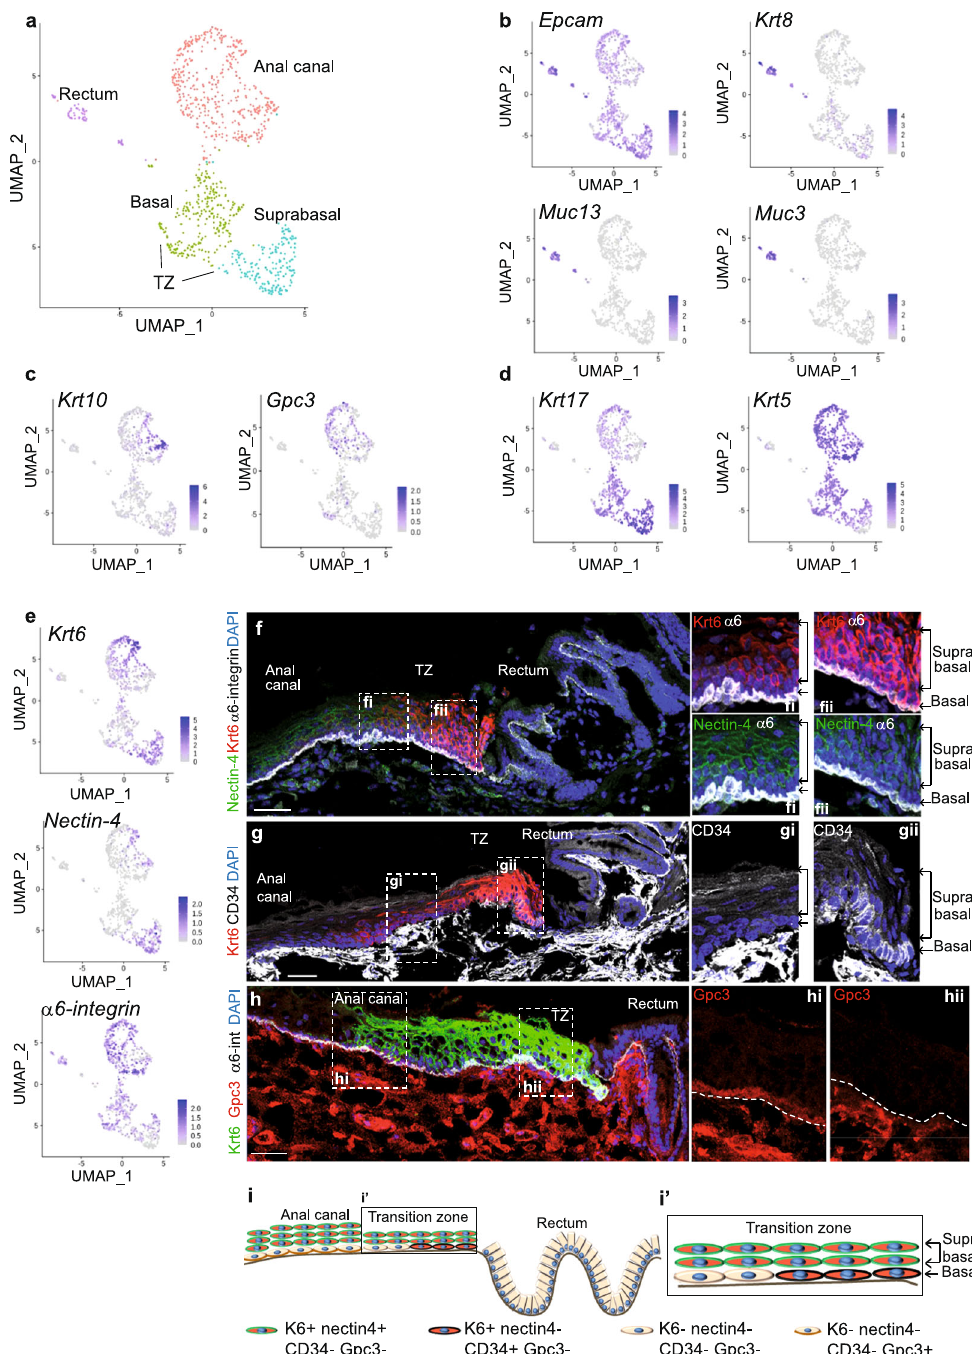
Fig. 2 Single cell analysis reveals hierarchical organization of the anal TZ cells. a Main cell populations visualized on Uniform Manifold Approximation and Projection (UMAP) dimensional reduction from scRNA sequencing of anorectal epithelial cells. Nine hundred and thirty-nine cells are visualized and colored by clustering. b – d Expression of key genes expressed in rectum, differentiated anal cells and TZ populations respectively. Darker color in the UMAP plot indicates higher expression level of the selected gene. e Expression of Krt6 and nectin-4 genes de fi nes the suprabasal TZ population. f Immuno fl uorescence with Krt6 (red), nectin-4 (green) antibodies con fi rms that TZ population can be separated into basal (expressing the polarized α 6-integrin in white) and suprabasal clusters ( n = 3 independent experiments from three mice). Scale bar is 50 μ m. fi , fi i are zoom 2,5-fold into the TZ closed to the anal canal and the rectum respectively. g Immuno fl uorescence with Krt6 (red), and CD34 (white) shows that TZ basal cells closed to the rectum express the stem cell marker CD34 ( n = 3 independent experiments from three mice). Scale bar is 50 μ m. Boxed areas gi and gii are shown at higher magni fi cation (2.5-fold). h Immuno fl uorescence with Gpc3 (red), Krt6 (green) and α 6-integrin (white) shows the speci fi c expression of Gpc3 in basal cells of the anal canal ( n = 3 independent experiments from three mice). Scale bar is 50 μ m. Boxed areas hi and hii are shown at higher magni fi cation (2.5-fold). i Representation of the TZ heterogeneity depending on cell positioning. i ’ Zoom into the